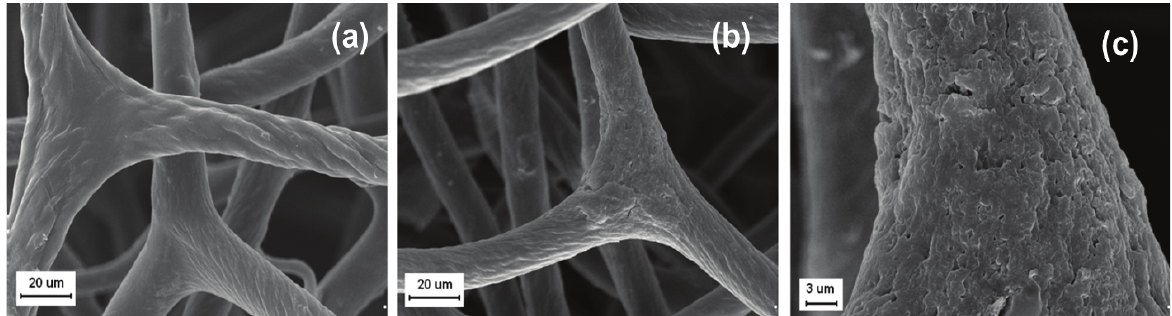
Figure 7: SEM of H. communis prior to (a) and after (b), (c) the adsorption process at different magnifications.